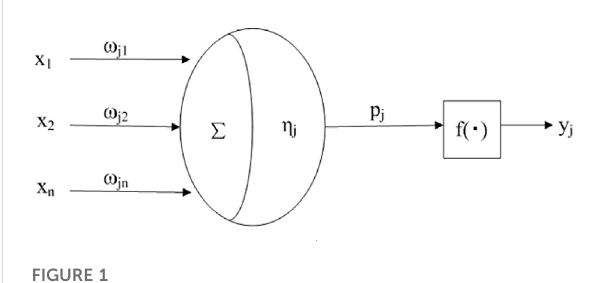
FIGURE 1 Element relation diagram of neural